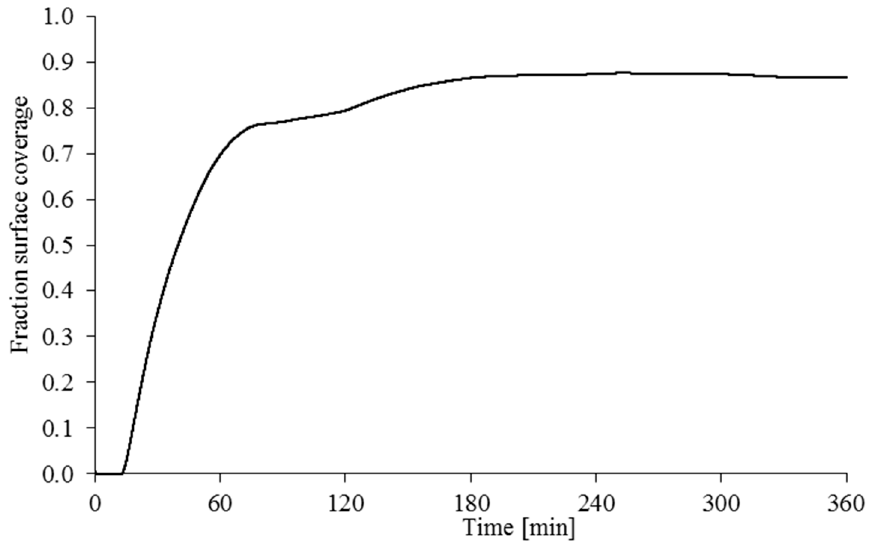
Figure 9. Total predicted fraction of substrate surface coverage in the test period.